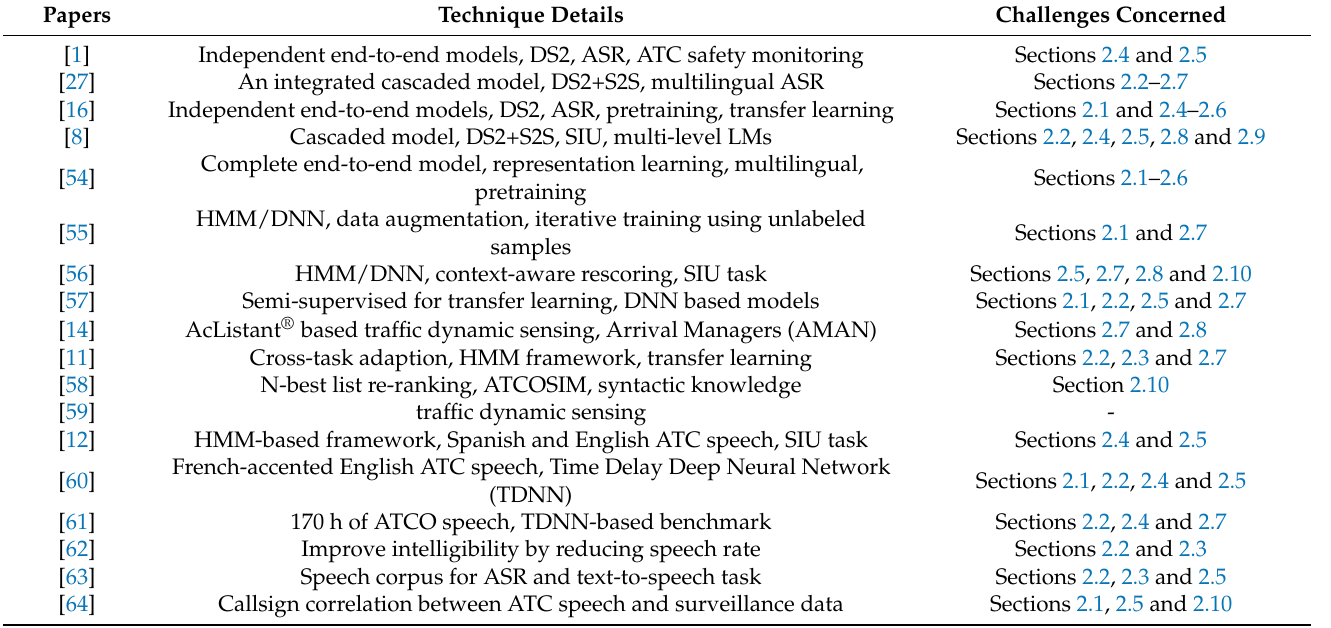
Table 4. The automatic speech recognition (ASR)-related studies in the ATC